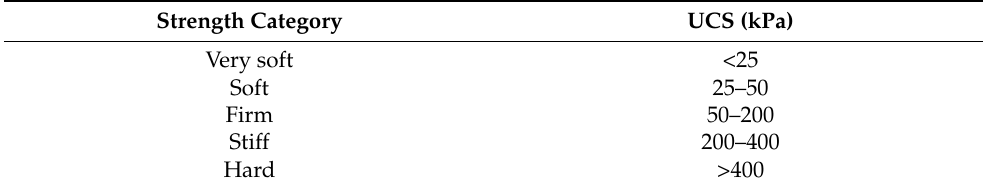
Table 4. Range of values of strength category for